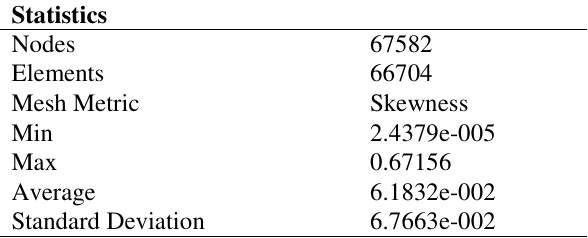
Meshing characteristics .